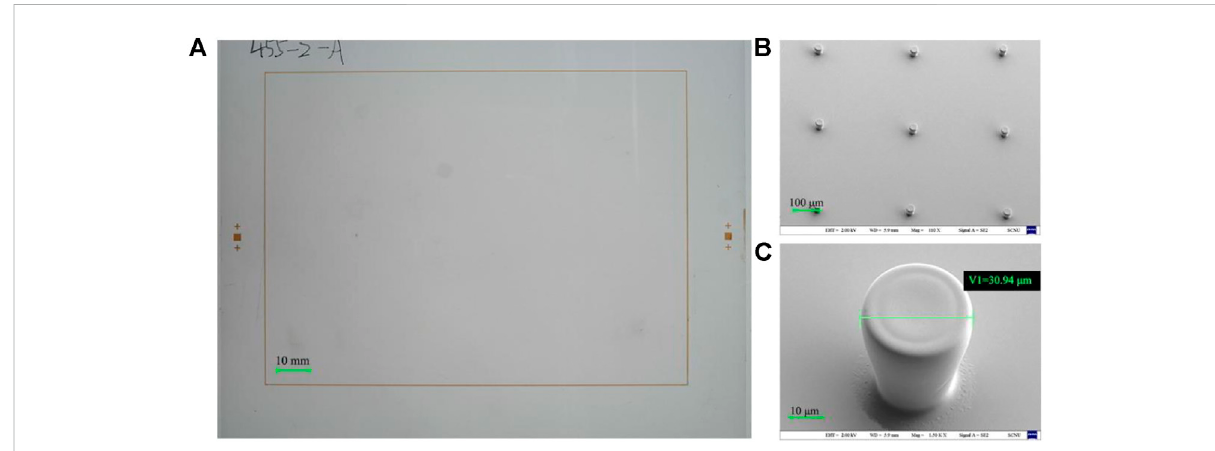
FIGURE 6 The as-prepared top substrate. (A) macro photo of top substrate was taken by a crammer, and (B) the spacer was taken under SEM with the parameters of EHT = 2.00 KV, WD = 5.9 mm, Mag = 110 X, Signal A = SE2. (C) Morphology of a single spacer under the SEM, Pixel wall width was